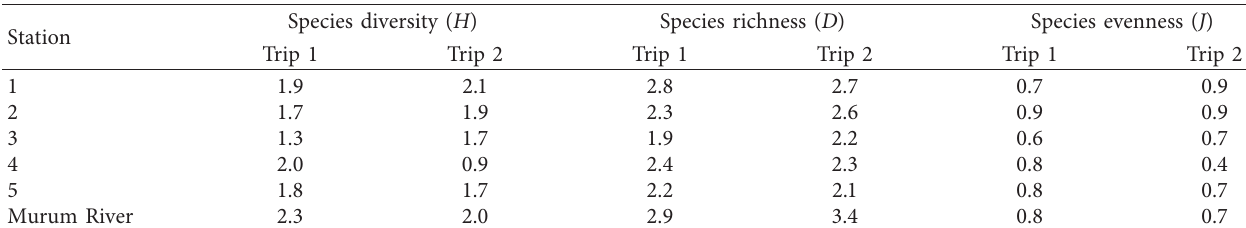
Table 2: Fish biological indices in the Murum River during the dry (trip 1) and wet (trip 2) seasons.